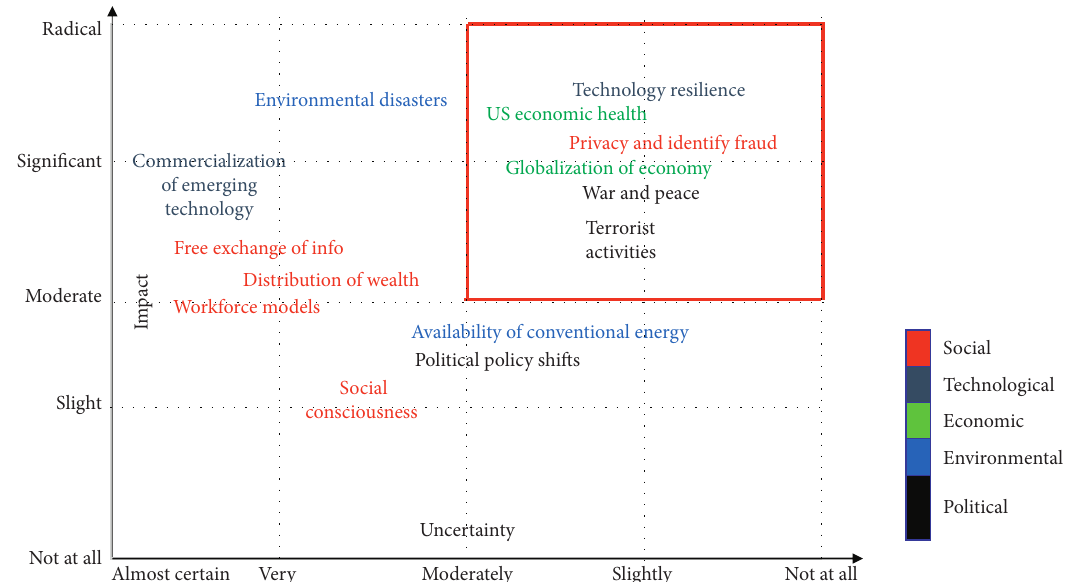
Figure 8: Rail and ground impact-uncertainty matrix. The impact type is shown on the right.